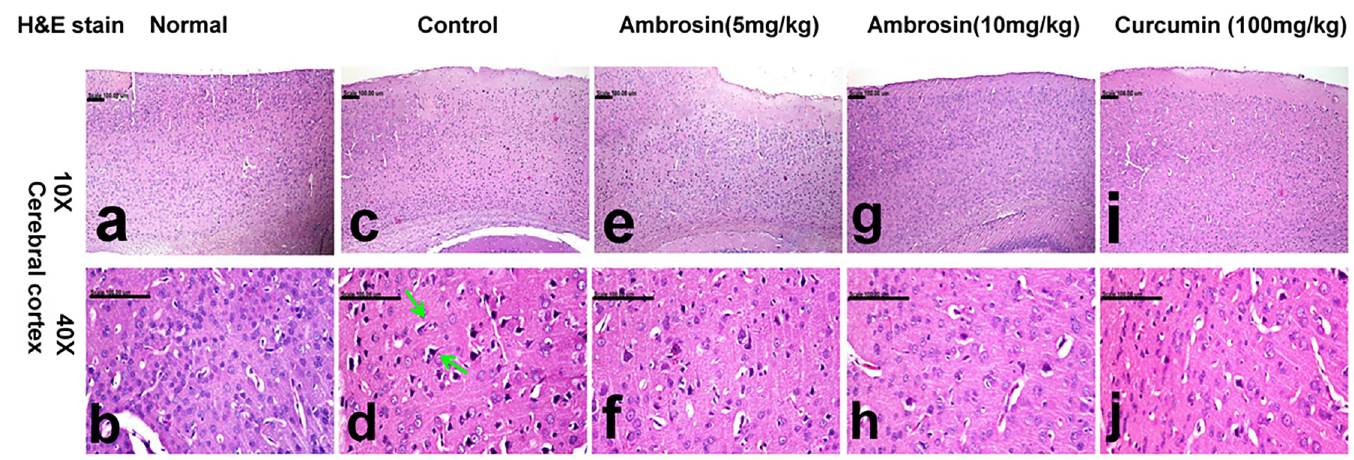
Fig 8. Histopathological lesions in the cerebral cortex of mice (magnifications: 10X, 40X). The photomicrograph illustrates the following groups: (a, b) normal mice showing normal cerebral cortex, (c, d) control mice showing neuronal degeneration associated with presence of neurofibrillary tangles (arrow) and amyloid plaque with eosinophilic core, (e, f) Ambrosin (5 mg/kg/day) treated mice showing neurons bearing tangles and gliosis, (g, h) Ambrosin (10 mg/kg/day) treated mice demonstrating lower number of degenerated neurons, and (i, j) Curcumin treated mice showing scattered degenerated neurons. (Haematoxylin and eosin stain, (H&E stain)).